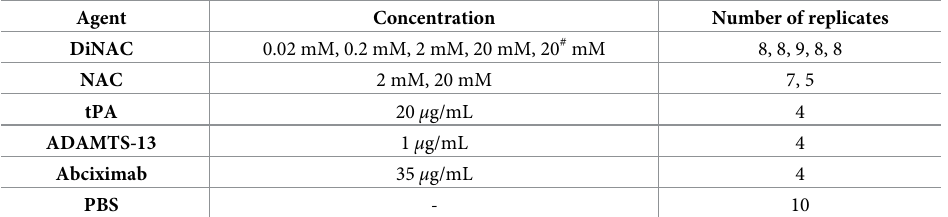
Table 1. Agent concentration and replicate